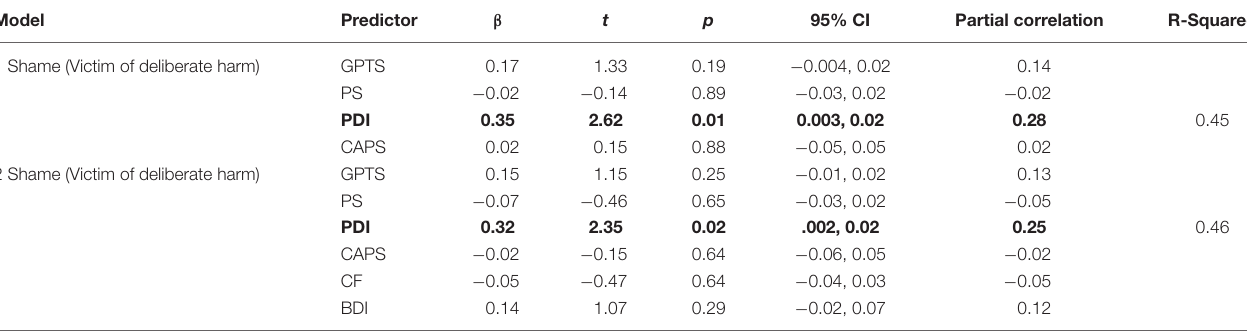
TABLE 2 | Hierarchical multiple regression analyses entering shameful feelings when the victim of deliberate harm as the dependent variable (Moral Emotions task). Model Predictor β t p 95% CI Partial correlation